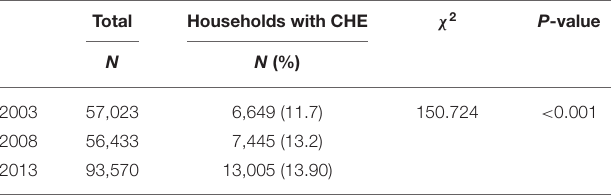
TABLE 2 | Catastrophic health expenditure incidences in 2003, 2008, and 2013.